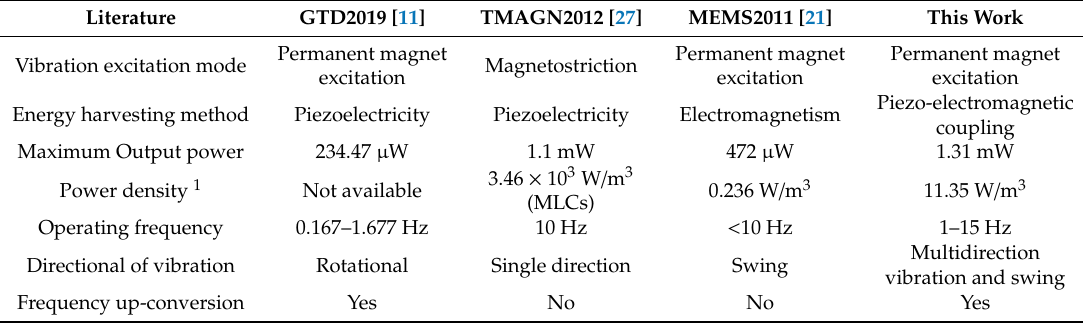
Table 1. Comparison of several vibration energy collection